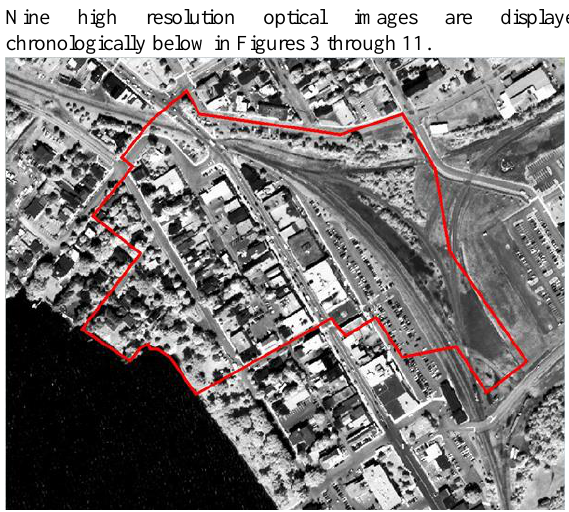
Figure 3. Pre-Derailment Image of Lac-Mégantic,